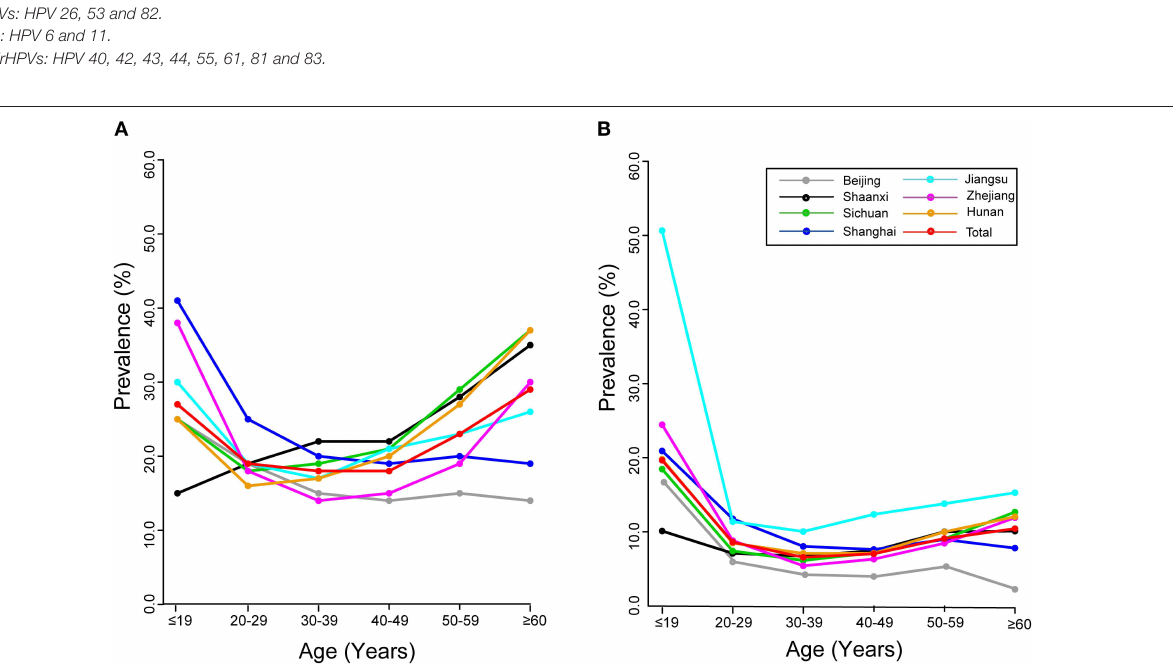
FIGURE 1 | Age-specific prevalence of HPV infection: overall and by region. (A) 17 hrHPVs. (B) 10